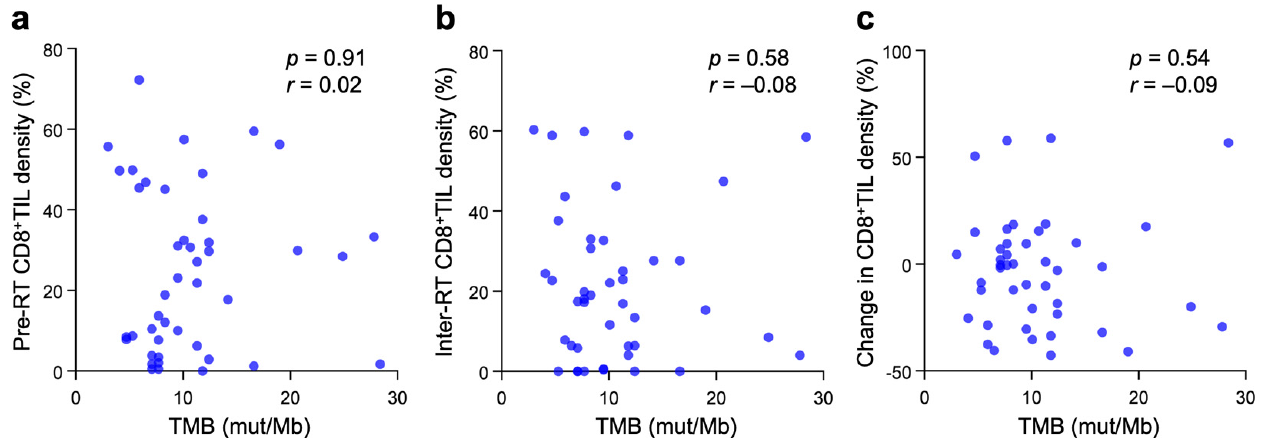
Figure 2. Correlation between TMB and pre-RT CD8 + TIL density ( a ), inter-RT CD8 + TIL density ( b ), or changes in CD8 + TIL density between the two timepoints ( c ) in patients with cervical cancer treated with definitive radiotherapy ( n = 44). p and r values, calculated by Spearman’s rank correlation test, are shown.